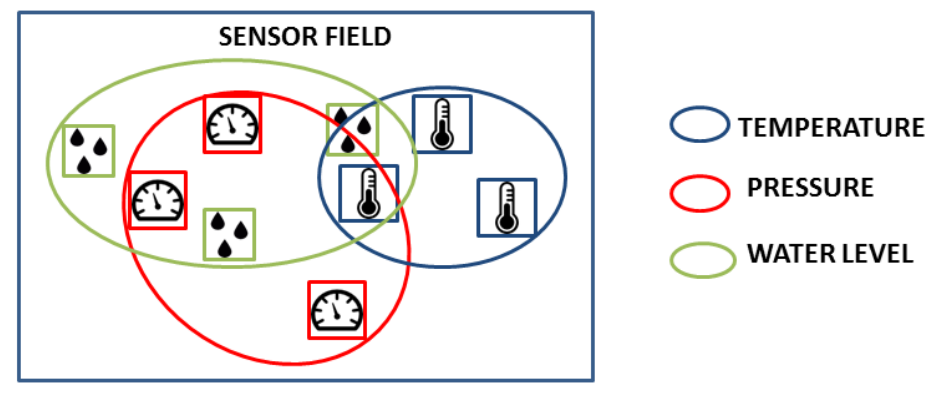
Figure 8. Filtering sensors using the property they